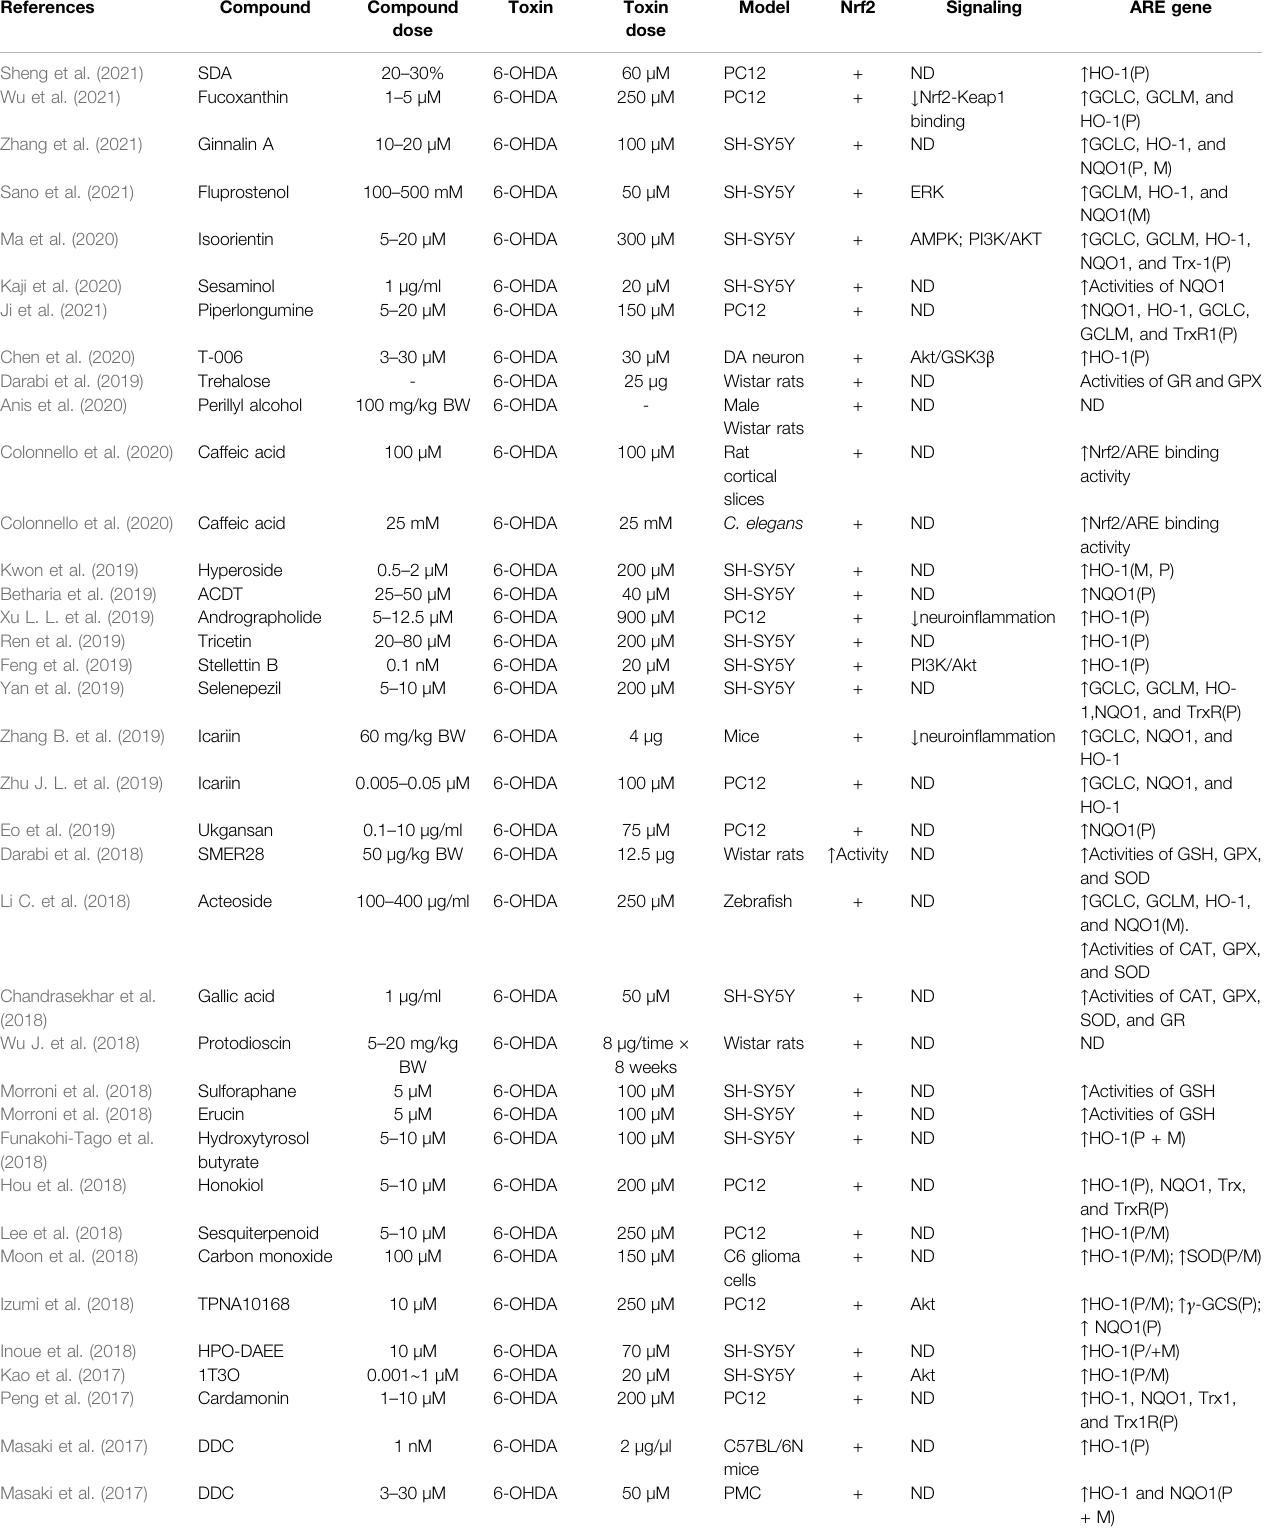
TABLE 2 | Summary of the experimental studies involving compounds able to modulate the Nrf2 pathway in 6-OHDA-induced PD